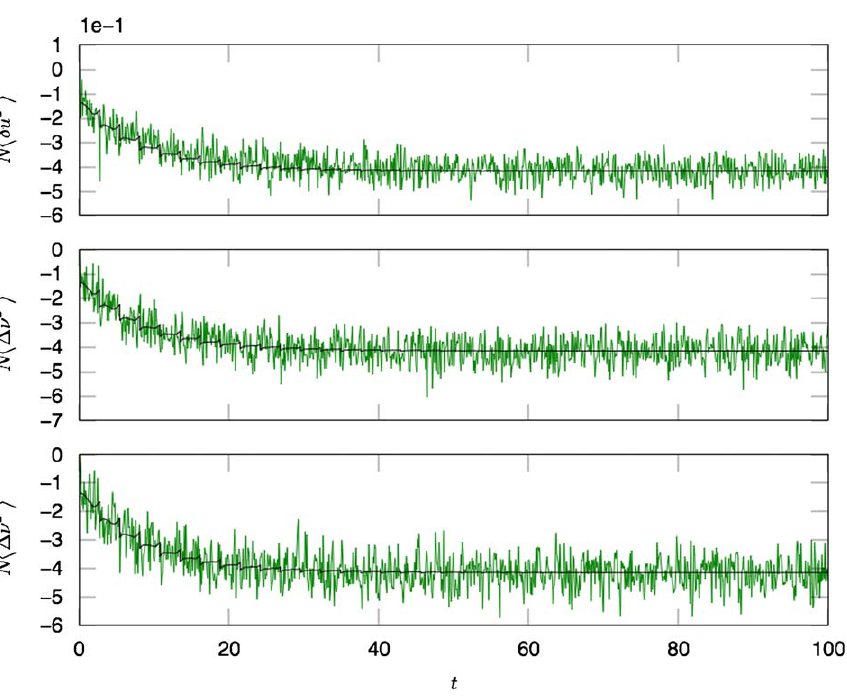
Figure 3. Numerical computations (green line) and analytical predictions (black line) of the firing rate fluctuations N S D n 2 T for the quadratic integrate-and-fire model for I ~ 1 : 0 , b ~ 1 : 0 , a ~ 1 : 0 for N ~ 10 (top), N ~ 100 (middle), N ~ 1000 (bottom) neurons with Poisson contribution subtracted. Ensemble average is taken over 1024000 samples.